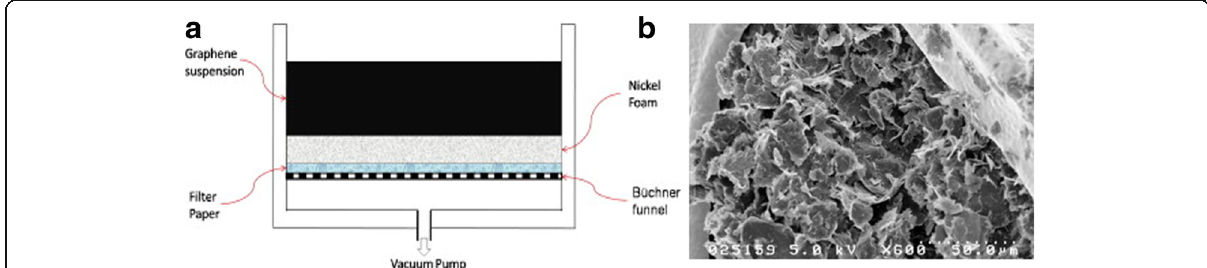
Fig. 1 a Schematics of vacuum filtration method to build graphene-containing supercapacitor electrode. b SEM image of graphene/PVDF on the nickel foam formed by vacuum filtration. Reprinted with permission from [10]. Copyright 2012